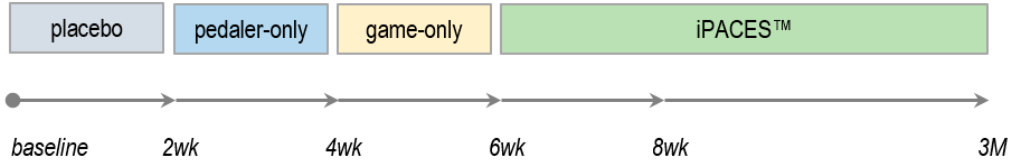
Figure 1. Pilot study design showing component familiarization periods leading to interactive Physical and Cognitive Exercise System (iPACES) intervention.